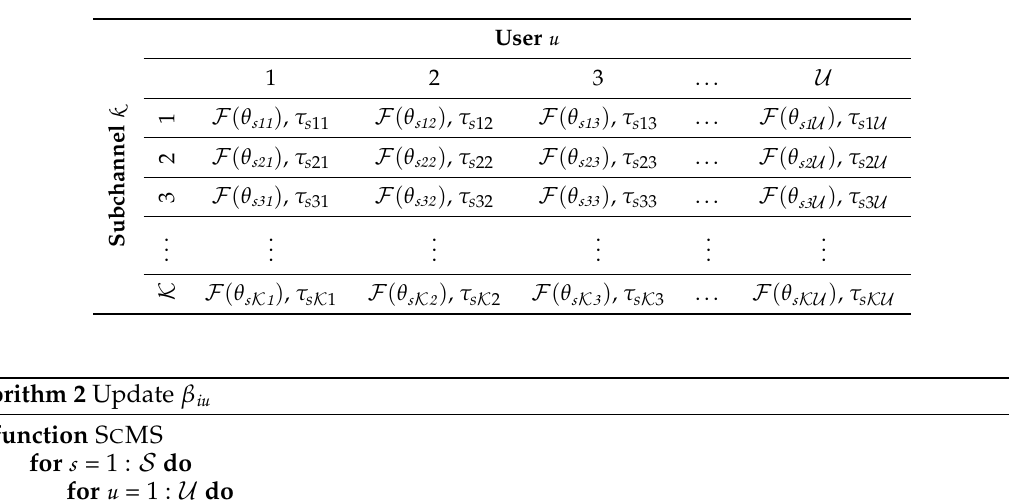
Table 2. ScMS transmission codebook for cell s .